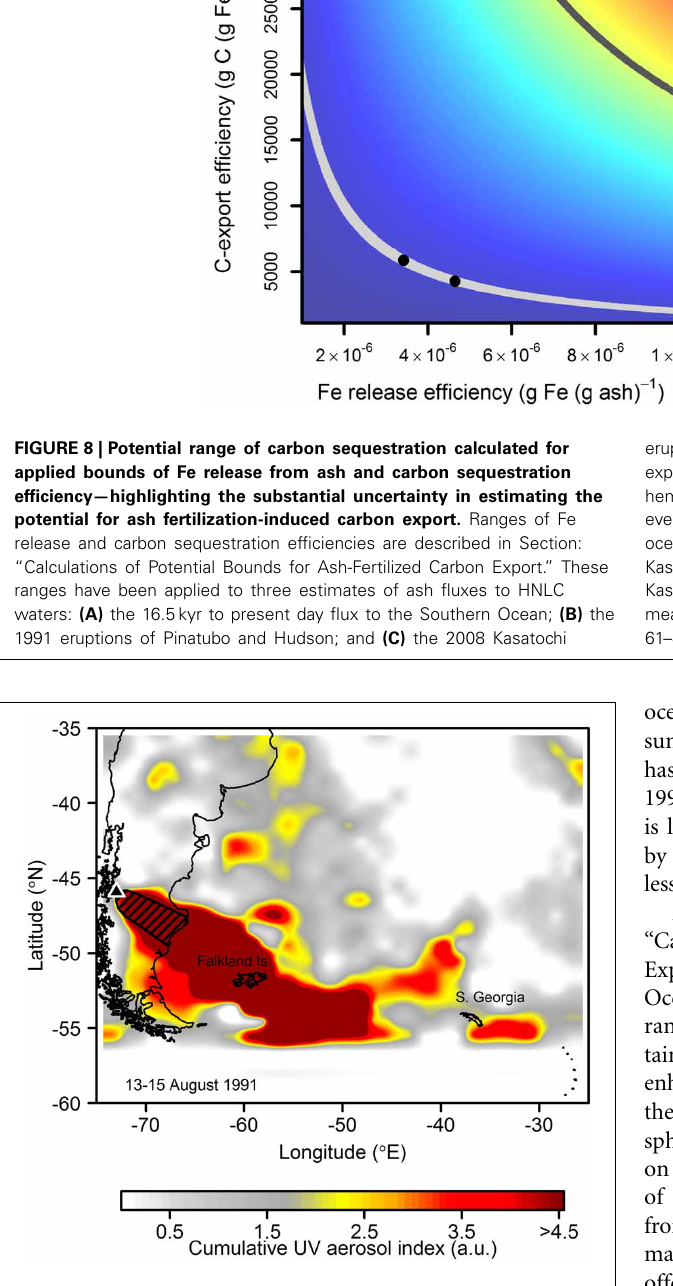
FIGURE 9 | Atmospheric aerosol loading for the main eruption period of Mount Hudson in August 1991 (product is UV aerosol index from Nimbus-7 Total Ozone Mapping Spectrometer (TOMS) summed over 13–15th May 1991) suggestive of significant ash deposition into the South West Atlantic and Scotia Sea. Hudson is identified with a black triangle. The hatched region shows the > 10mm isopach (ash thickness) for the eruption which has been mapped out on land (Scasso et al., 1994). Ash deposits from the eruption have been found deposited on the Falkland Islands (Kratzmann et al., 2010) and South Georgia (Smellie,